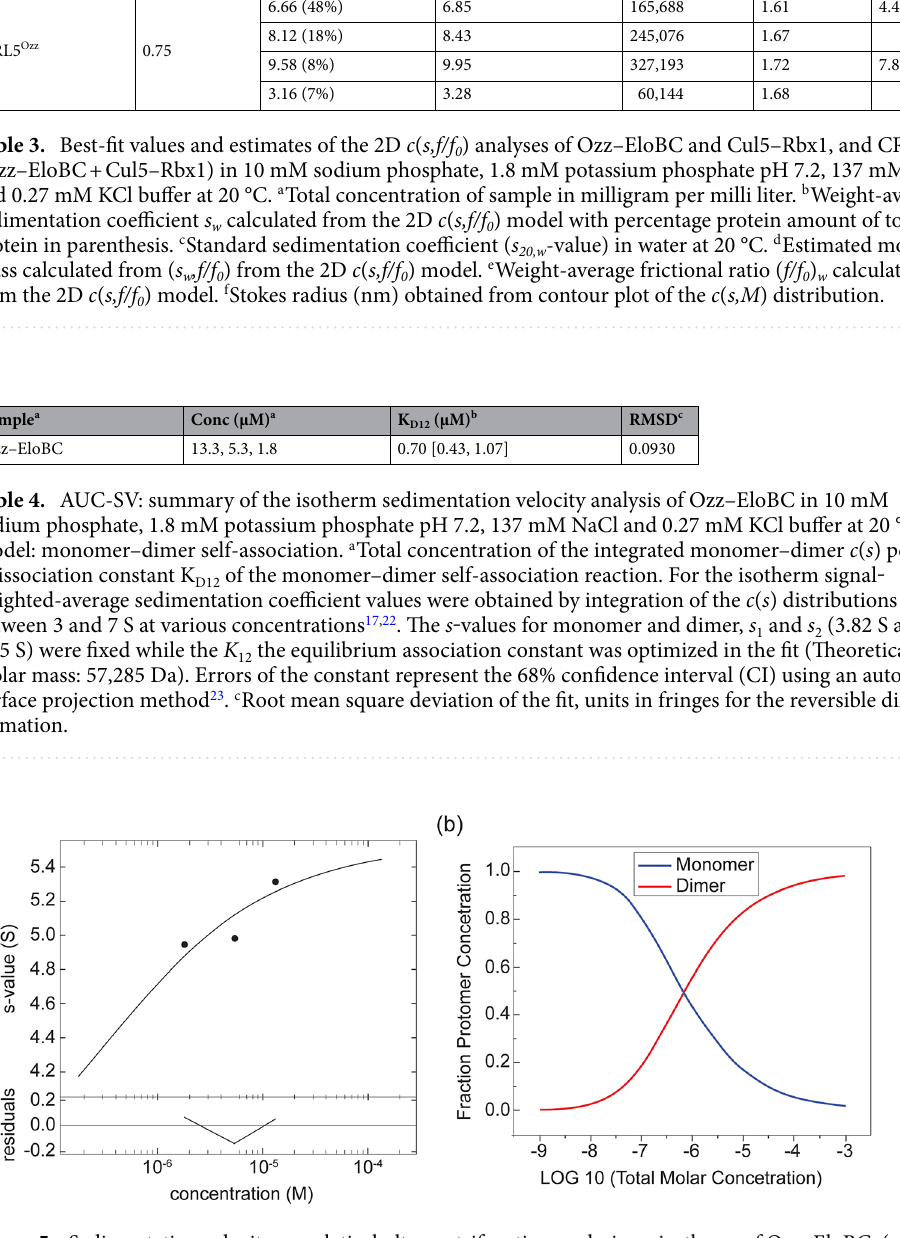
Figure 5. Sedimentation velocity—analytical ultracentrifugation analysis, s w isotherm of Ozz–EloBC. ( a ) The best-fit isotherm of the signal-weight-average s-values, s w , obtained by integration of c ( s ) distributions of Ozz– EloBC over the s-range of 3 and 7 S for each loading concentration in a dilution series. The solid line is the fitted isotherm to a reversible monomer–dimer self-association model with the best-fit dissociation constants K D12 value as well as confidence intervals and the root mean square deviation of the fits at all the concentrations listed (Table 4). ( b ) The species population plots of fraction protomer concentration vs log total concentration (Molar) with the amounts of monomer and dimer at specific concentrations determined by the K D12 value of the self- association model are also